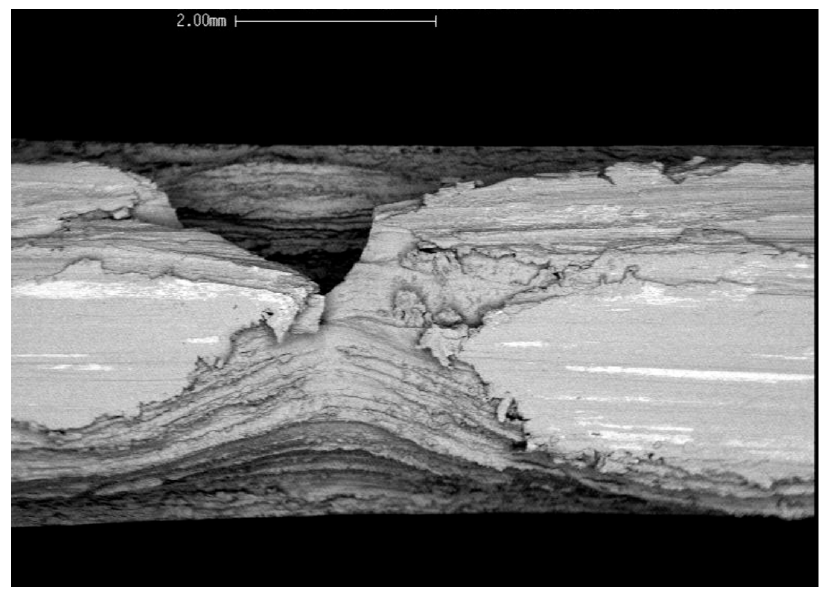
Figure 2. SEM images of the surface of a jagged bar.